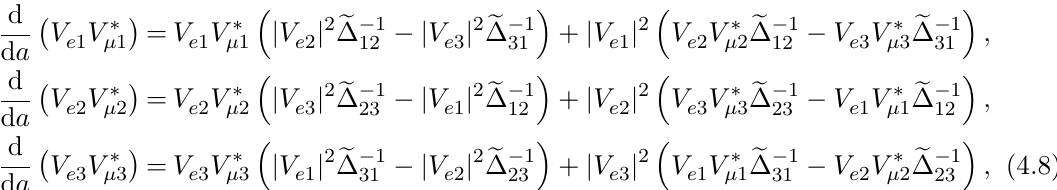
and with respect to a= (cid:1) A L A R